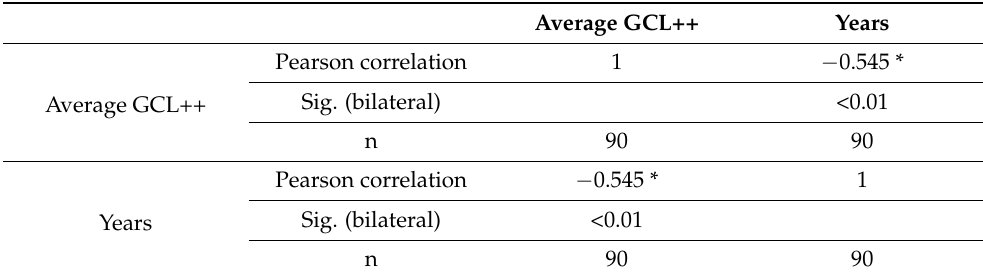
Table 11. Correlation between the number of years since CM diagnosis and the average thickness of the GCL++.